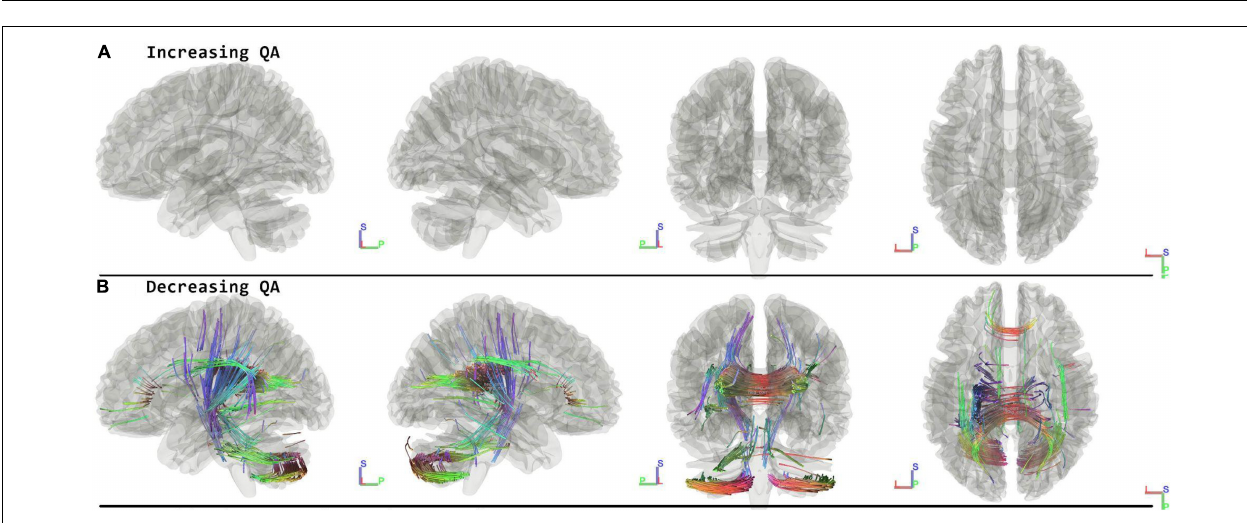
FIGURE 4 | Tracts associated with changes of followup minus preflight. There are no significant changes in increasing QA (A) . For decreasing QA there were changes in the corpus callosum, cerebellum, lemniscus, corticopontine tract, and corticostriatal tract (FDR = 0.0069) (B) . Blue indicates superior – inferior. Green indicates anterior – posterior. Red indicates left –